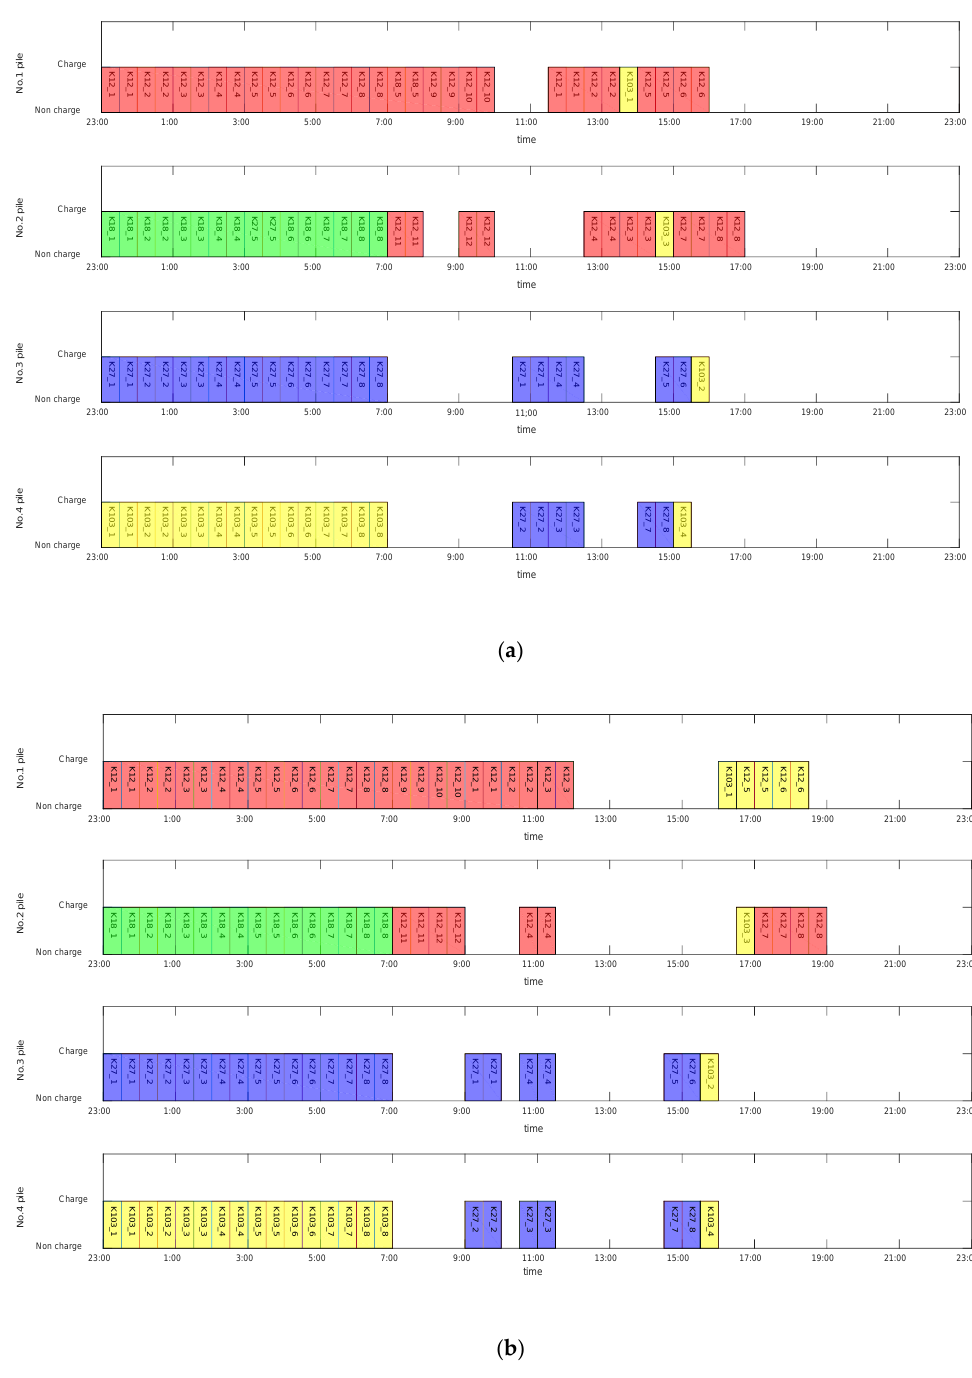
Figure 9. ( a ) Electric buses scheduling without charging optimization of Case 3; ( b ) Electric buses scheduling without charging optimization of Case 3.